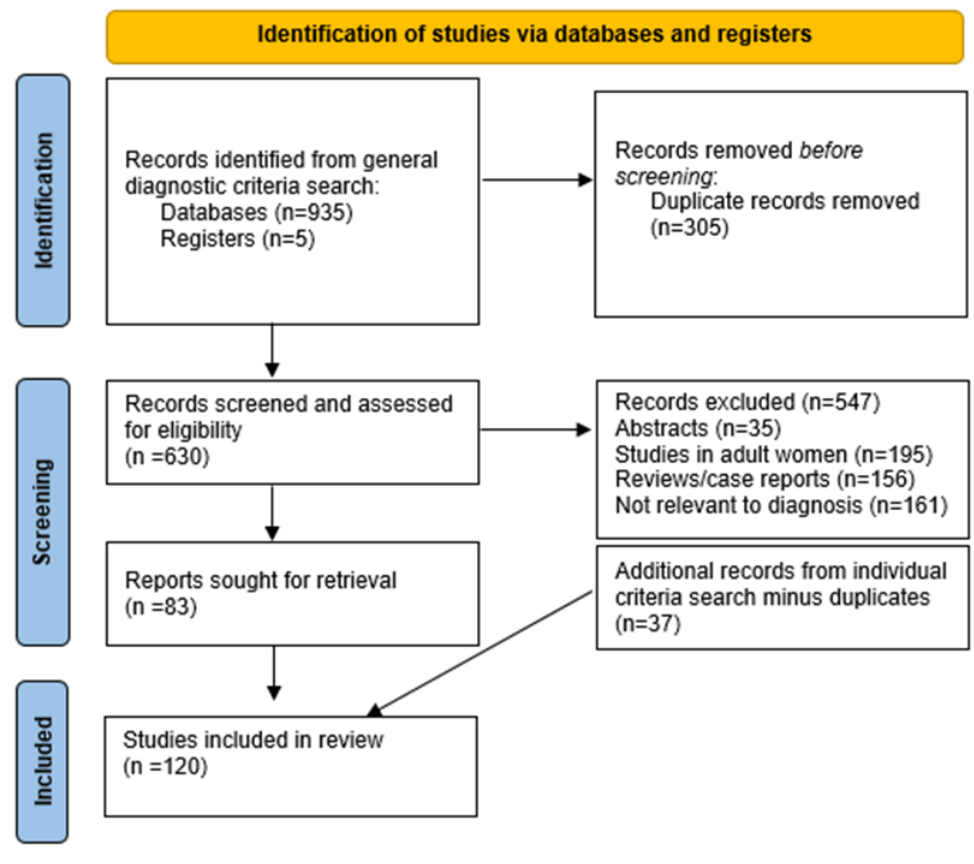
Figure 1. PRISMA search flow algorithm.